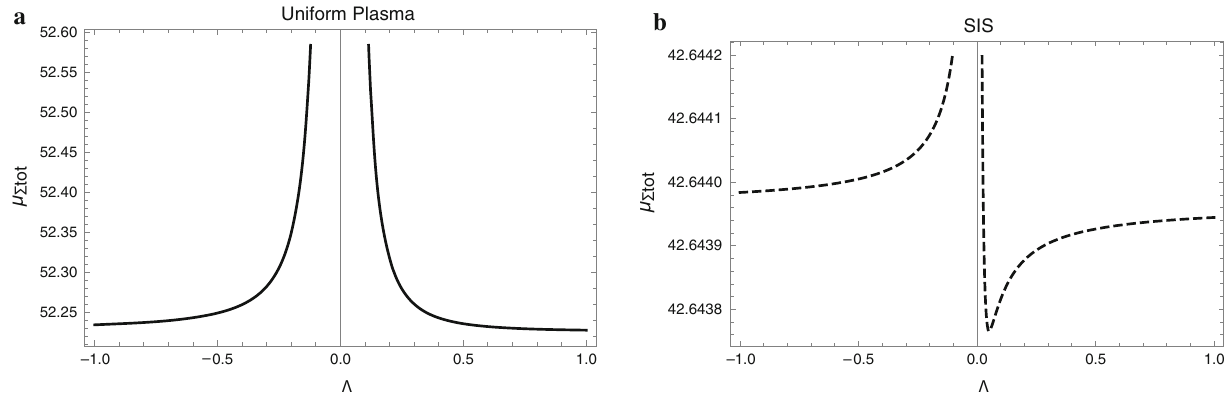
Fig. 17 a Plot of μ Σ tot vs. Λ when β = 0 . 001 for uniform plasma. b Plot of μ Σ tot vs. Λ when β = 0 . 001 for the SIS distribution. In all the figures we considered D ls = 10, D l = 100, D s = 110, ω 2 e /ω 2 = ω 2 c /ω 2 = 0 . 5, θ E = 0 . 001818, and ˜ J r = 0 .